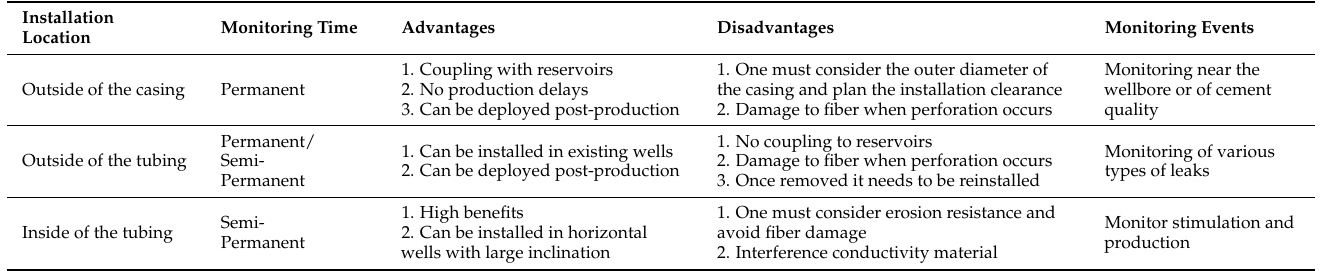
Table 1. Advantages and disadvantages of different installation positions of optical